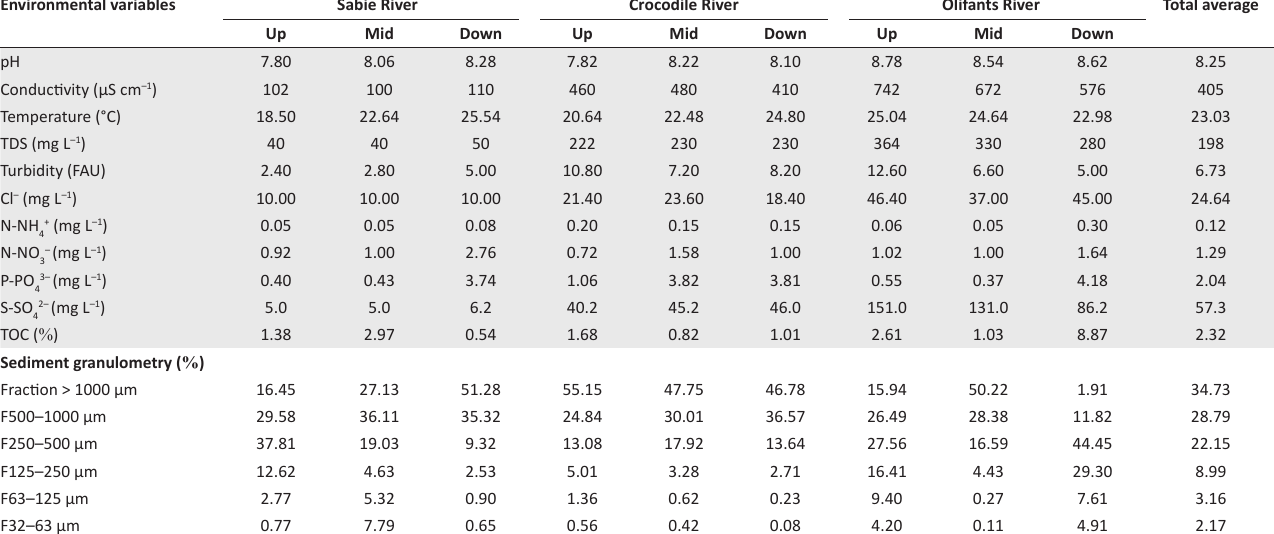
TABLE 1: Water and sediment environmental parameters measured at three sites along three rivers flowing through the Kruger National Park. Environmental